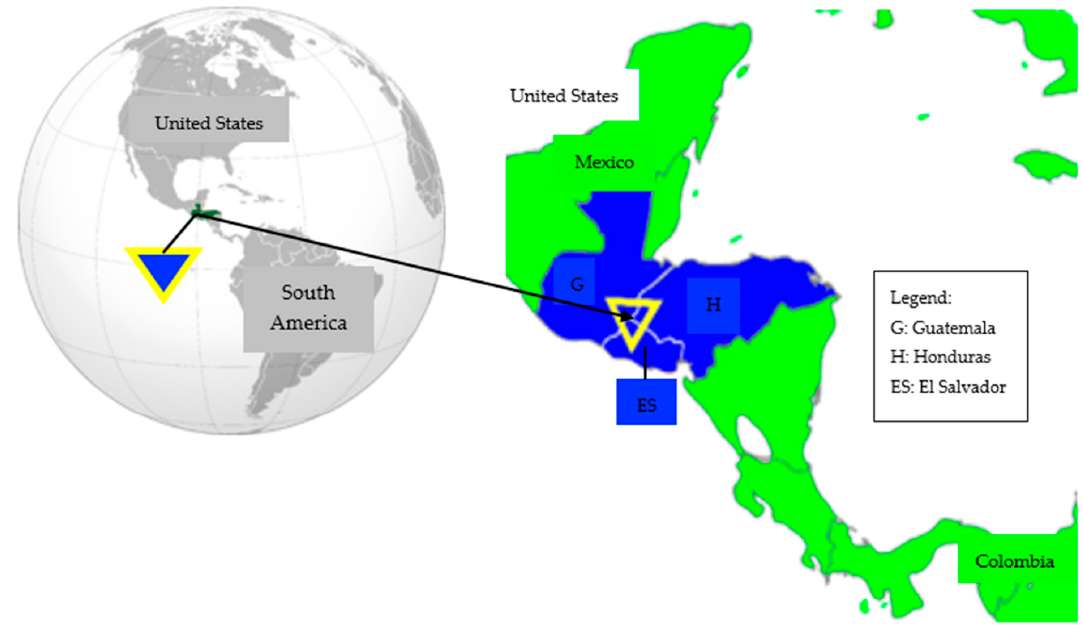
Figure 1. Map of Central America’s “Northern